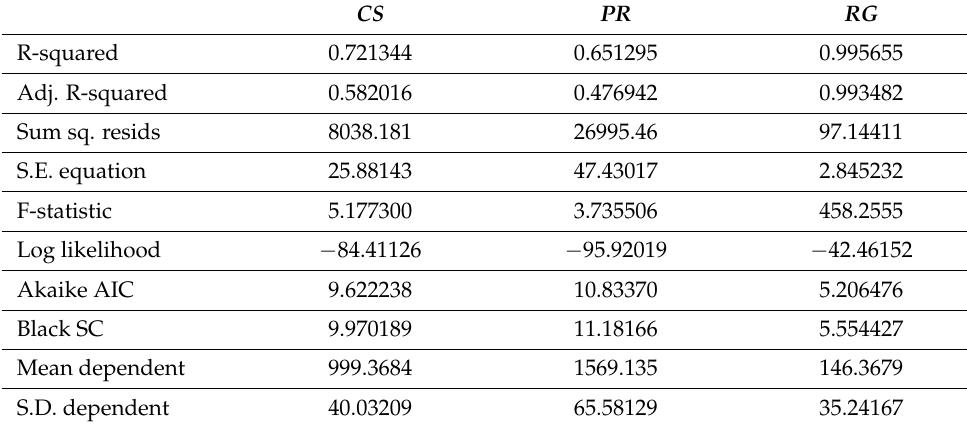
Table 5. Vector Autoregression Estimates.